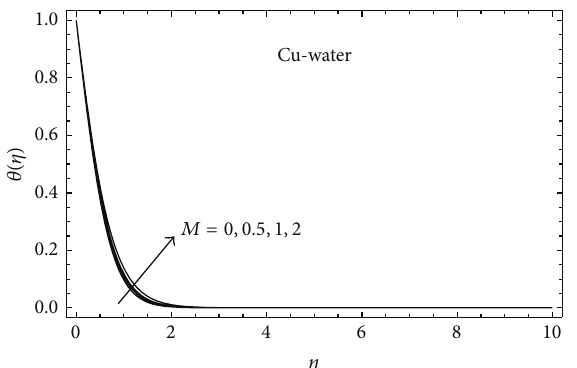
Figure 5: Effect of 𝜆 on velocity distribution 𝑓 󸀠 (𝜂) for Pr = 6.2 , 𝑀 = 1 , and 𝜙 = 0.1